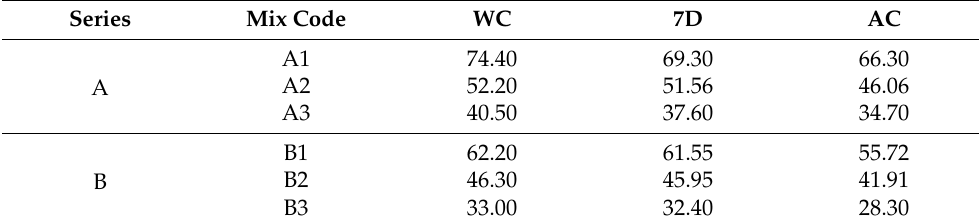
Table 6. Compressive strength at 28 days under different curing conditions